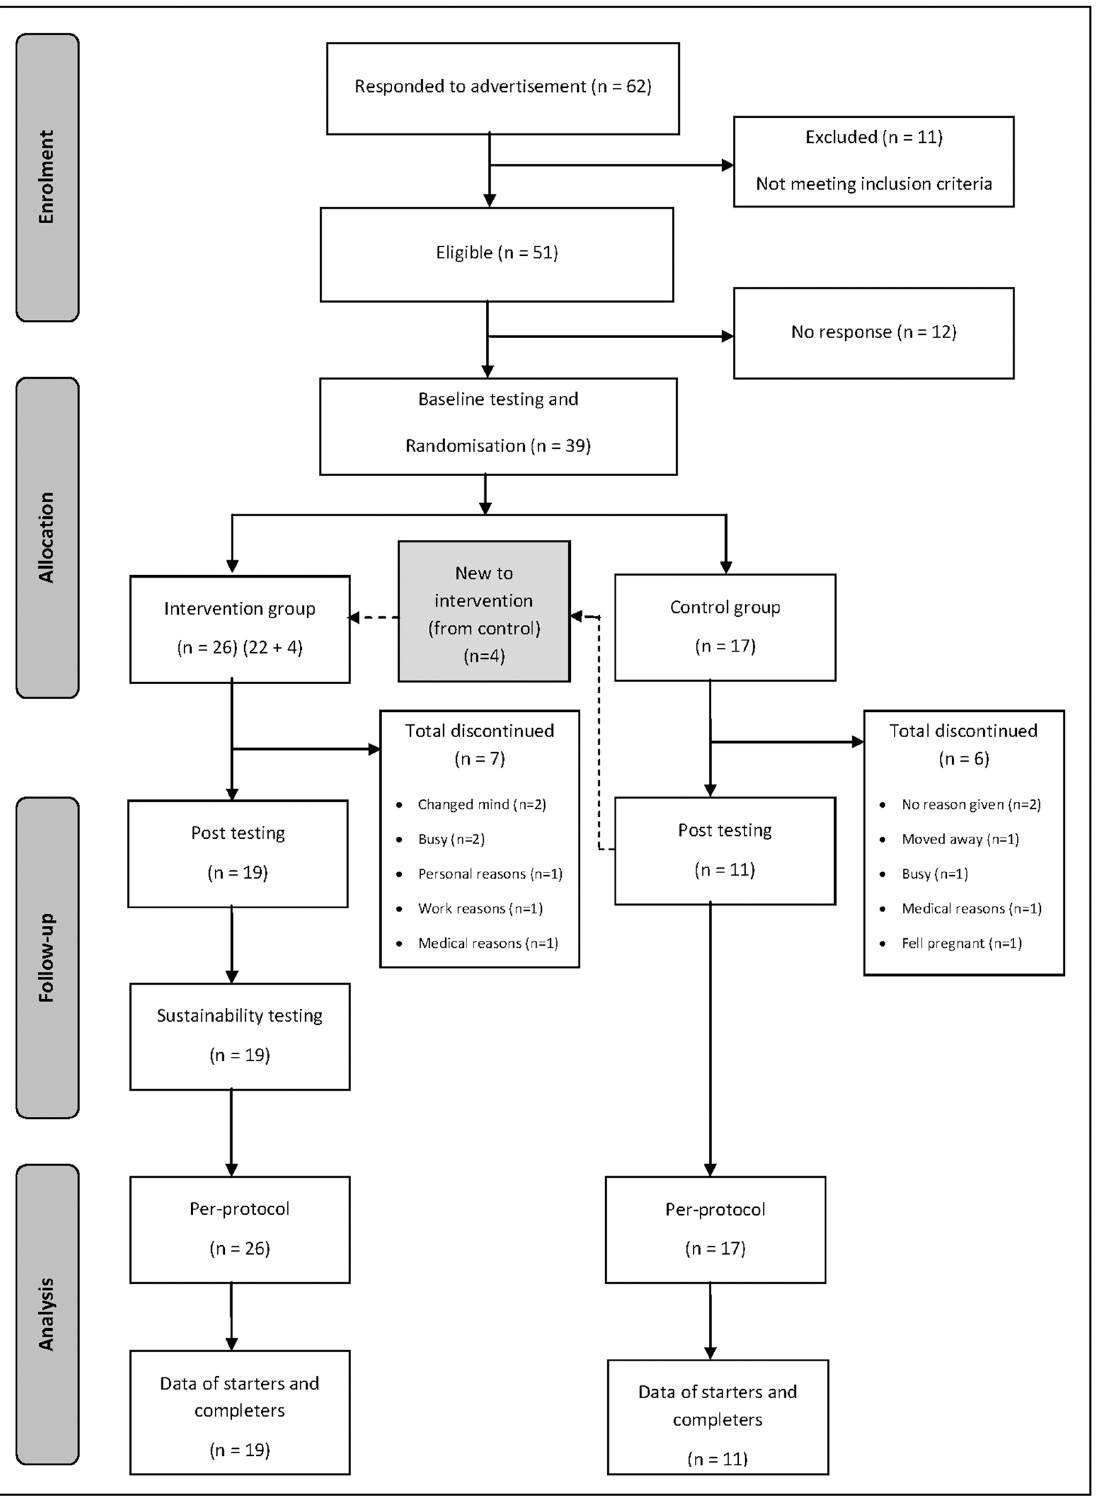
Fig 1. CONSORT participant flow-chart of intervention and control participants.